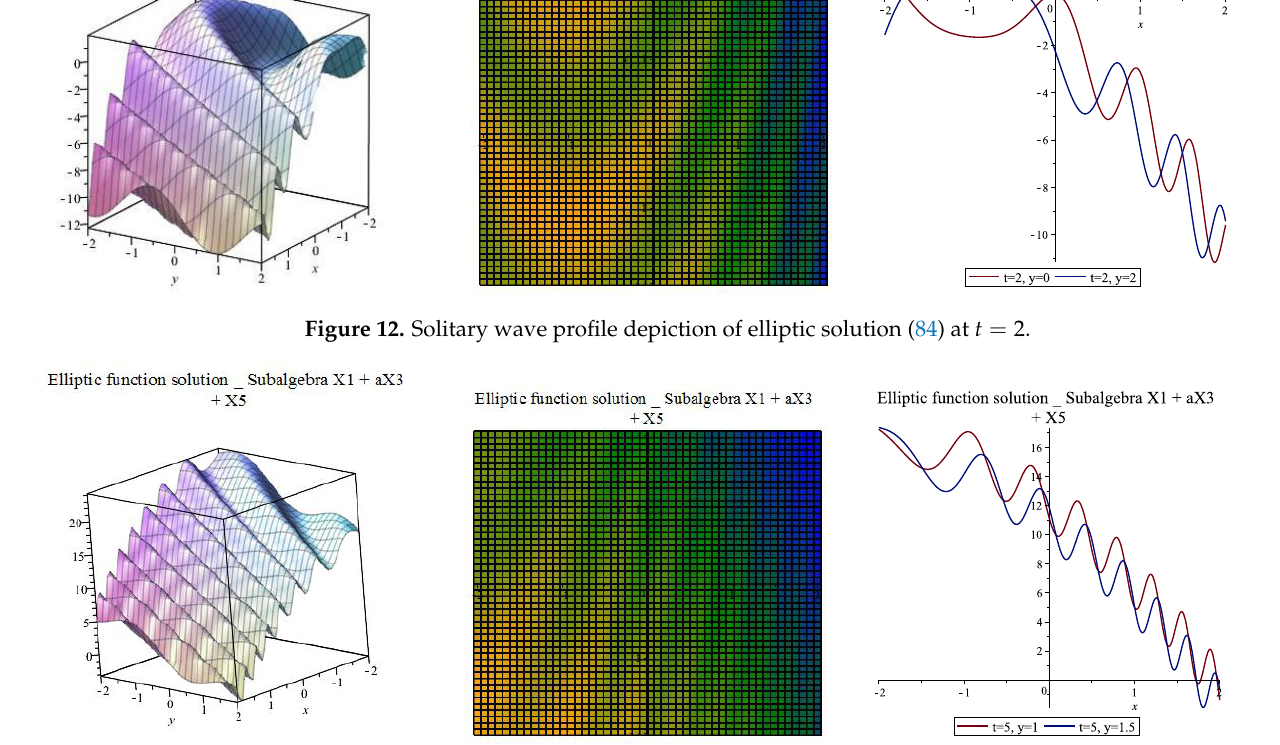
Figure 13. Solitary wave profile depiction of elliptic solution (84) at t = 5.